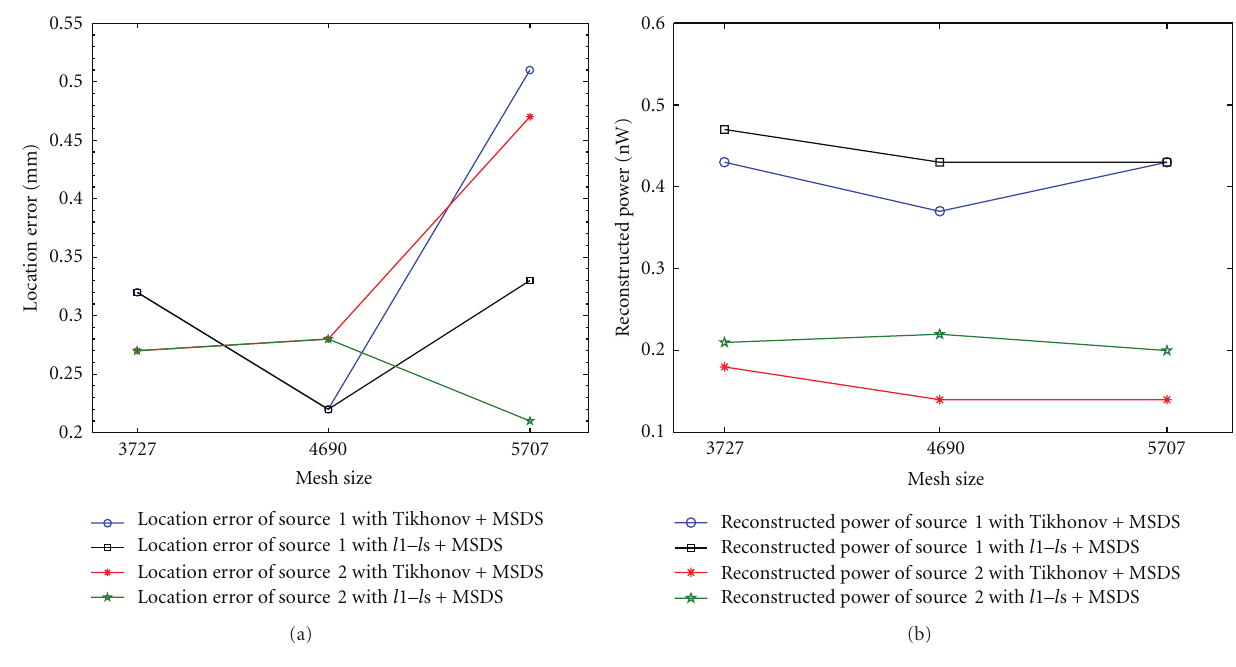
Figure 6: (a) Location error under di ff erent mesh levels. (b) Reconstructed power under di ff erent mesh levels. Table 2: Reconstruction results in double-source